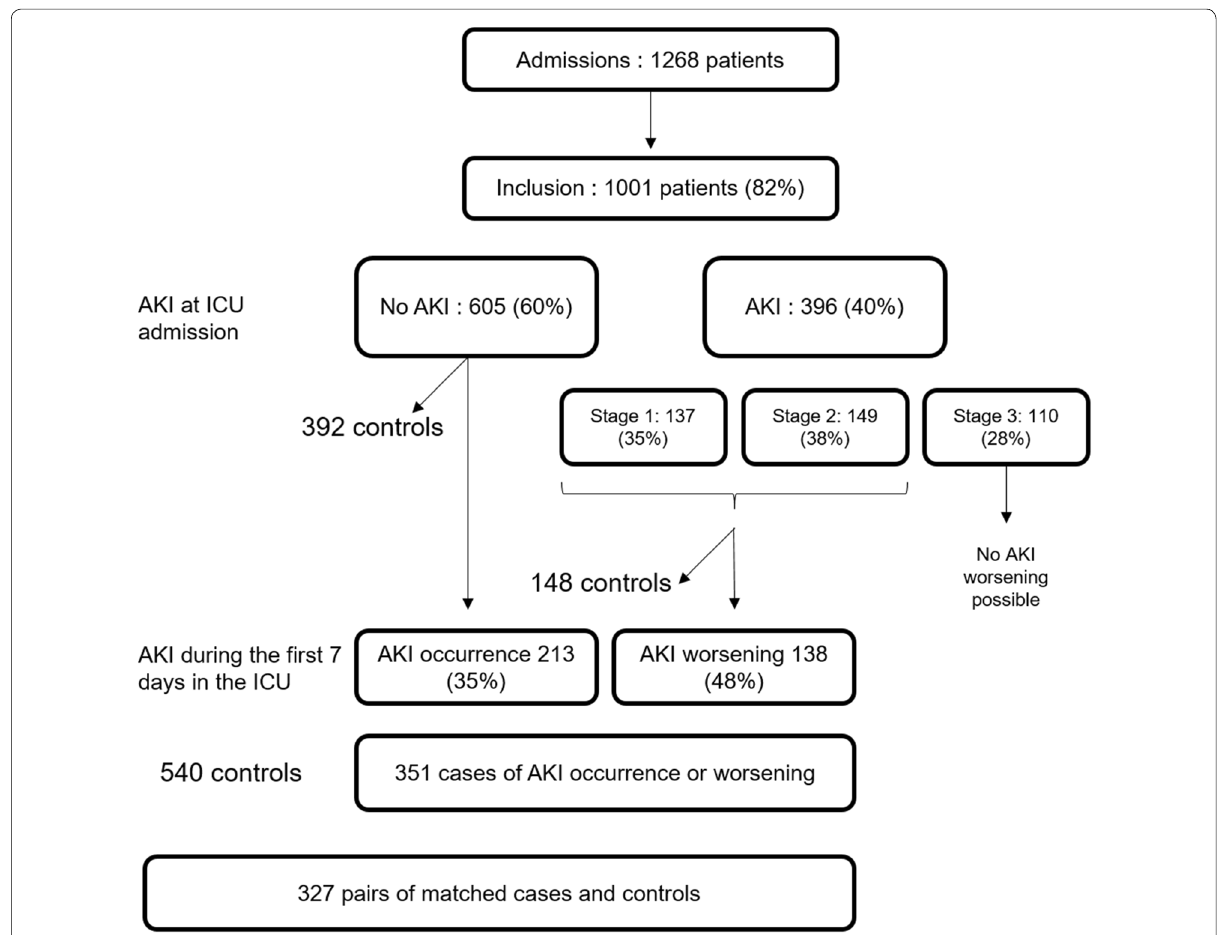
OR of 1.26 IC 95 [1.03–1.56], p 0.026. Among the sick- = est patients (admission SAPS2 higher than 48), the asso- ciation did not reach statistical significance: OR 1.13 IC 95 [0.92–1.37], p 0.245 (Fig. 3). Nephrotoxic bur- = den among cases of AKI occurrence/worsening and of controls was plotted according to severity of disease in Fig. 4. Interestingly, whereas nephrotoxic burden stead- ily increased with severity of disease among control patients, the opposite was observed for cases of acute kidney injury occurrence/worsening (Fig. 4). Sensitiv- ity analysis performing matching without replacement of controls showed results similar to the primary analy- sis: OR 1.19 IC 95 [1.12–1.27] ( p 0.004), as well as using = wider matching margins (data not shown). Sensitivity analysis among the subgroup of patients admitted with- out AKI showed results similar to the whole population in favor of a significant impact of nephrotoxic burden on AKI occurrence: 192 cases matched with 192